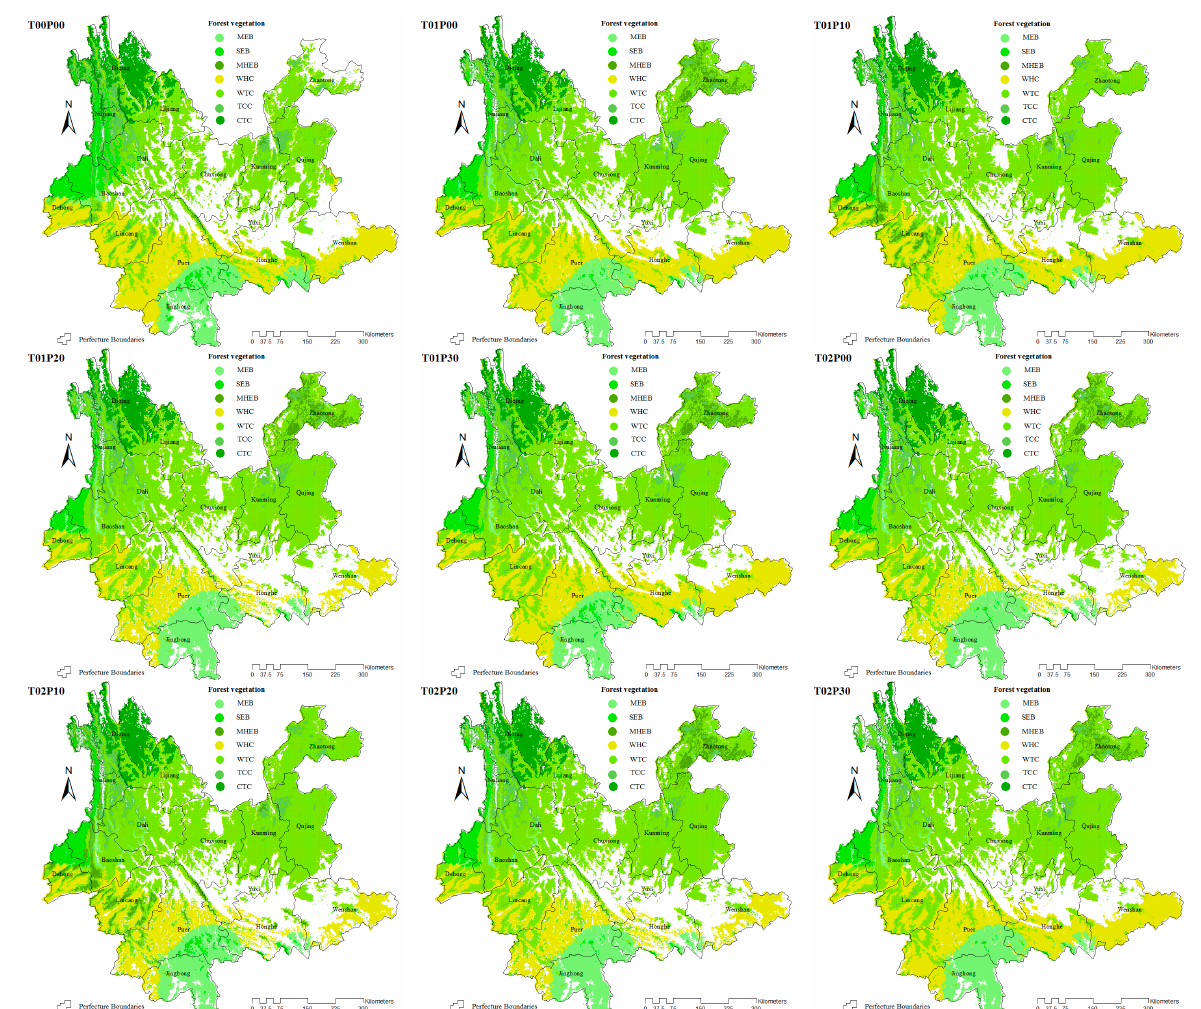
Figure 1. Potential spatial distribution of the forest vegetation in Yunnan Province under different simulation scenarios. Table 3. Rate of change in the forest distribution area under scenarios with a temperature increase of 1 °C and different decreases in precipitation. Units: Area, ×10 5 ha; Rate of change, %.